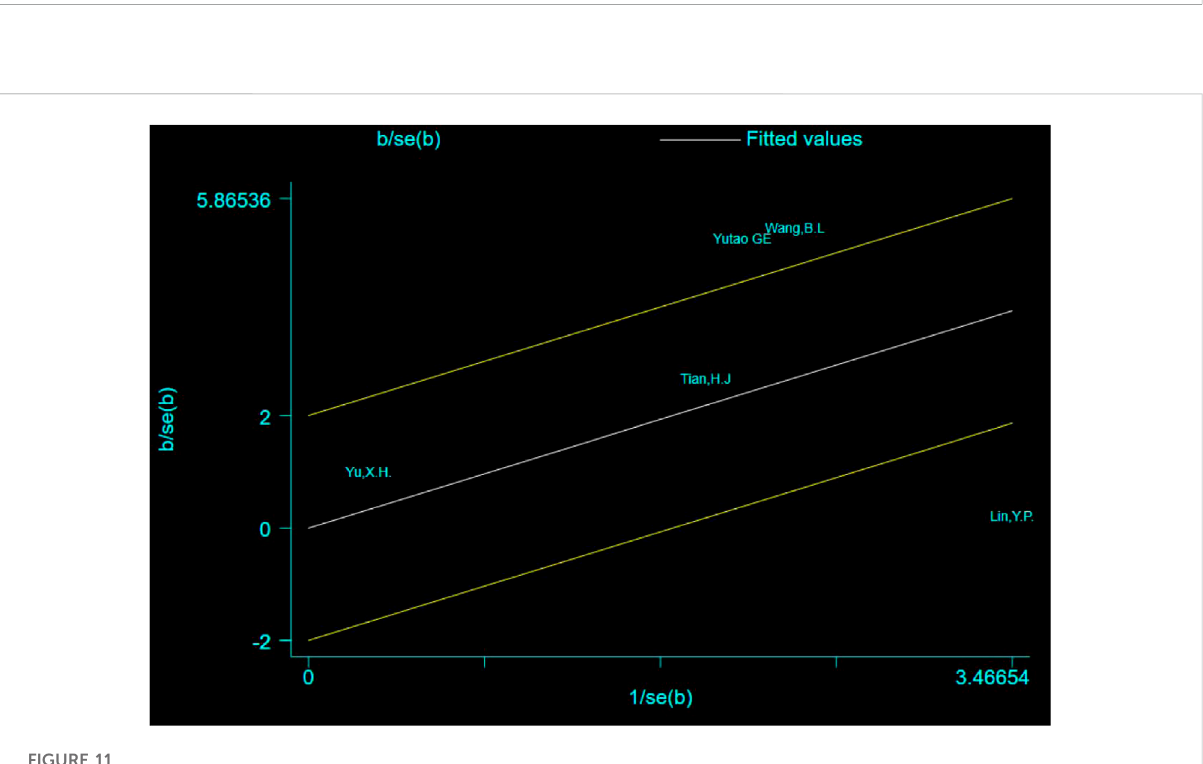
FIGURE 11 Galbraith plot for the outcome of the times of crossing